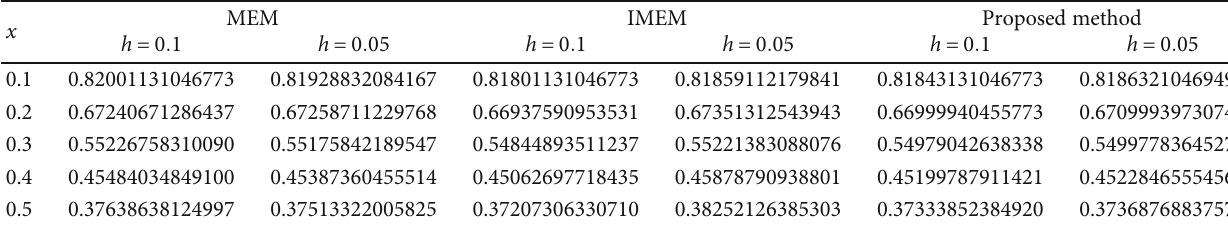
Table 1: Numerical solutions for Example 1.